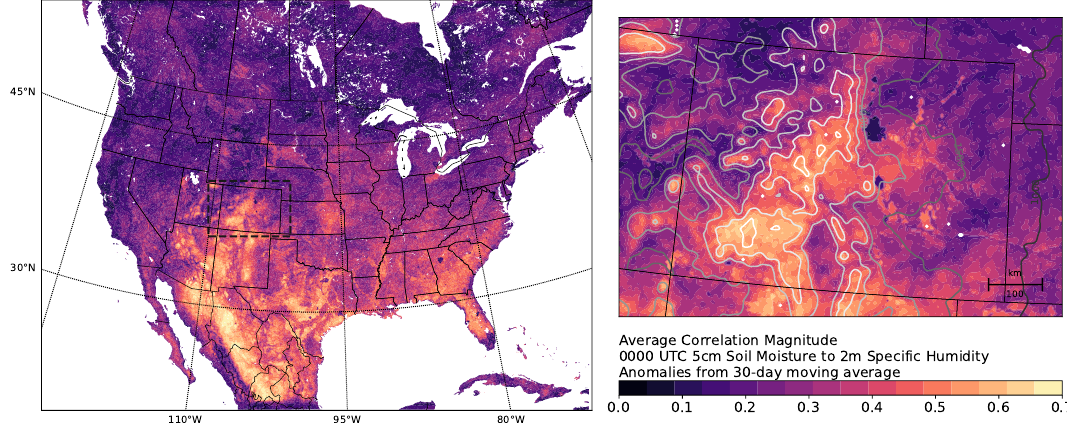
Figure 2. Same as Figure 1, but for a simulated 2-m water vapor mixing ratio and 5-cm soil